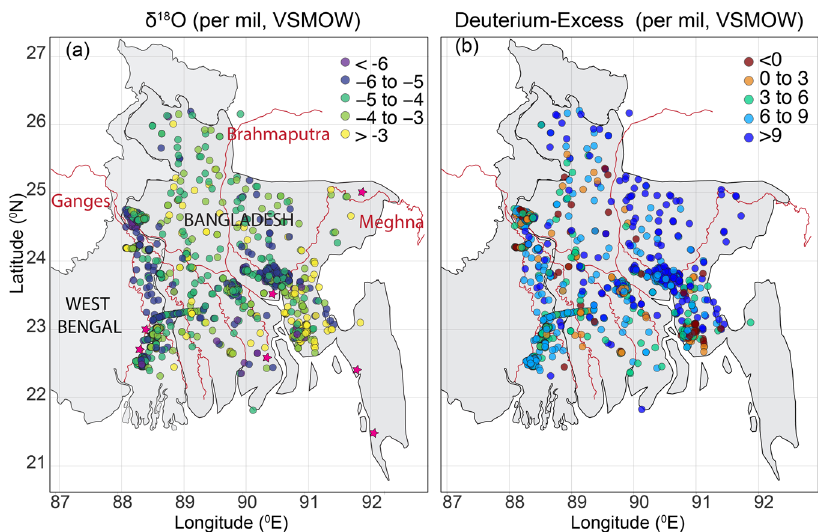
Fig. 2 Spatial distribution and isotope ratios of groundwater samples. δ 18 O ( a ) and d-excess ( b ) of georeferenced groundwater samples (circles) across the Bengal basin (Bangladesh and West Bengal, India). The three major rivers, Ganges, Brahmaputra, and Meghna, and their tributaries are shown in red lines. Samples that were not georeferenced but included in the mixing model analysis have not been shown here. Groundwater δ 18 O and d-excess values across the basin were not spatially correlated (Moran ’ s I statistics were 0.18 and 0.11, p < 0.005 for δ 18 O and d-excess, respectively). The approximate locations of the precipitation station are shown as purple stars (panel a